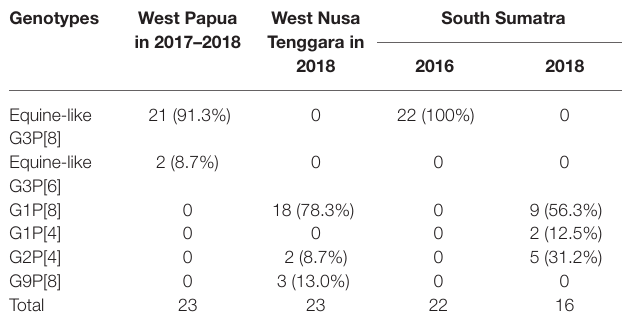
TABLE 3 | Geographic distribution of rotavirus G and P genotype combinations in